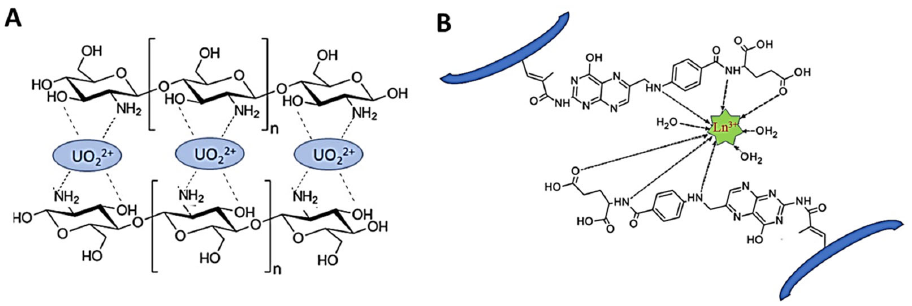
Figure 19. ( A ) Coordination of uranyl ions in active sites on the CS surface (adapted from Ref.